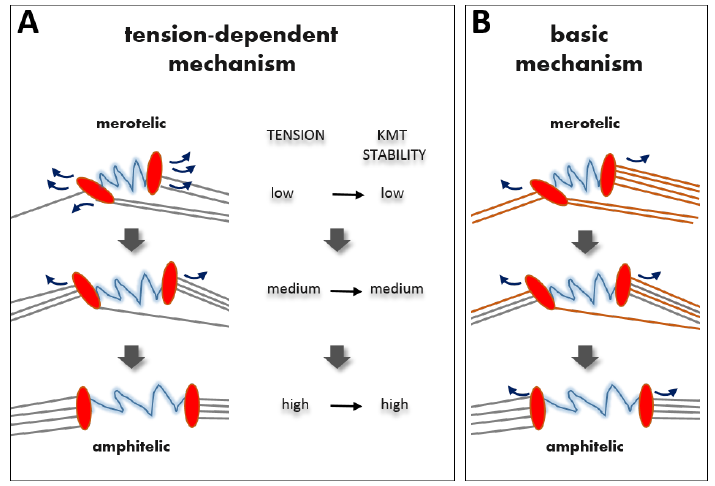
Figure 3. Models for correction of merotelic KMT attachment errors. Correction of merotelic attachments in vertebrate cells proceeds gradually during prometaphase and metaphase without necessarily losing all KMT attachments. ( A ) In the tension-dependent error-correction model, stretching between sister kinetochores (red ovals connected with blue springs) is the primary signal that modulates the turnover of KMT attachments (depicted with curved arrows). As kinetochores bind and lose KMTs, probing different configurations, the configurations that produce higher tension are assumed to induce higher KMT stability. Because their KMTs detach less frequently, such configurations last longer. This gradual evolution would lead eventually to the completely amphitelic configuration, which generates maximal tension. In the non-discriminate version of this model (as shown), all KMTs are affected similarly. Alternatively, in the selective version of this model, lifetime of merotelic vs. amphitelic KMTs is assumed to be regulated differently (see text for details). ( B ) In the basic mechanism, the gradual correction of merotelic attachments proceeds with no change in the turnover of KMT attachments. The rate of KMT turnover in this model does not depend on tension and is not selective, so all old KMTs (orange) eventually detach, whether correct and incorrect, and are replaced with new KMTs (grey). New KMTs preferentially attach correctly, favored by the back-to-back geometry of sister kinetochores.